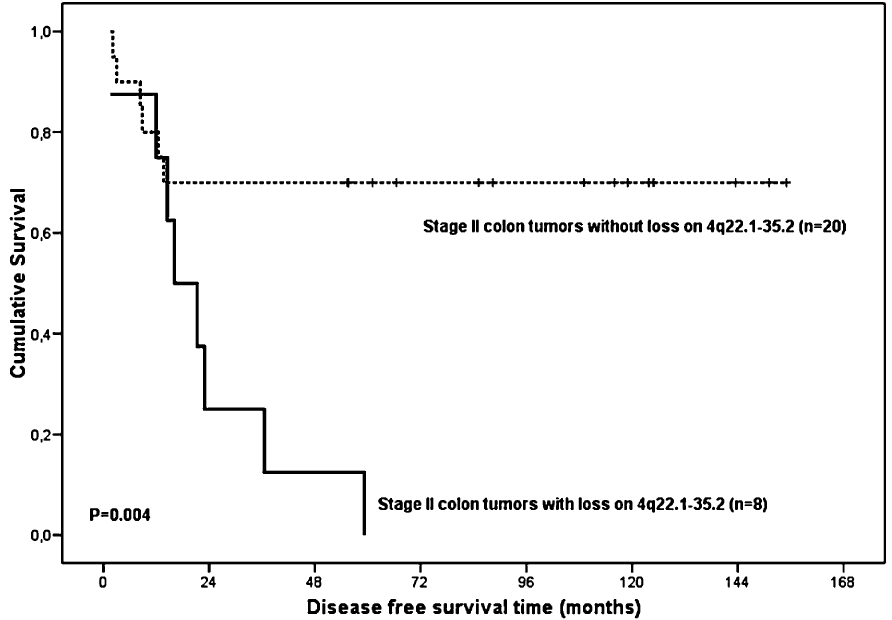
Fig. 4. Kaplan–Meyer disease-free survival plot of 28 MSS stage II colon cancer patients stratified for any loss of chromosome 4q22.1–q35.2. Stage II colon tumors with any loss on chromosome 4q22.1–q35.2 showed worse disease-free survival than without losses on 4q22.1–q35.2 ( p = 0 .